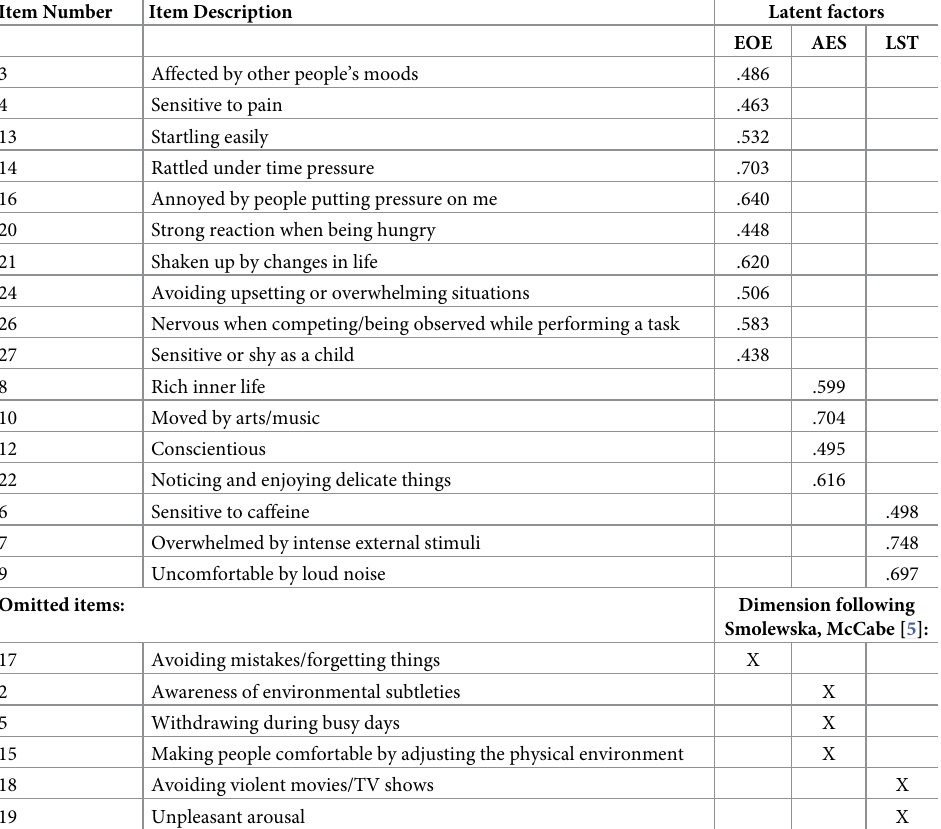
Table 3. Overview of the SPS subscales and their standardised factor loadings in the final reduced hypothesised measurement